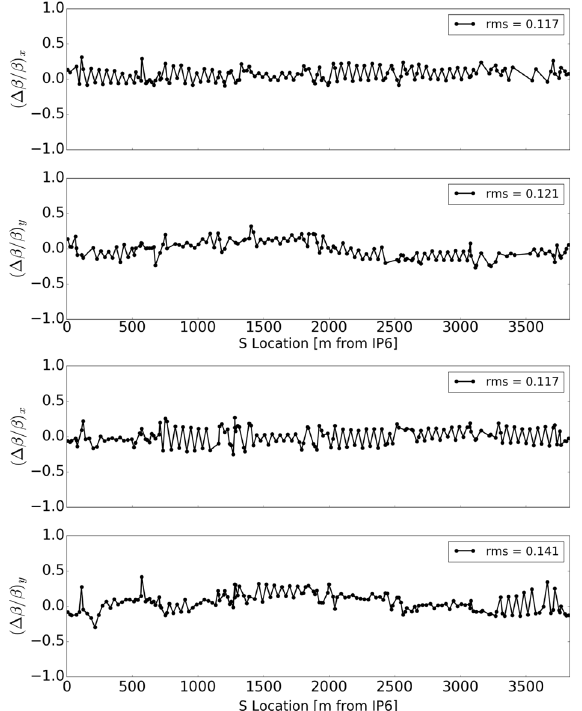
FIG. 11. Measured β -beat ð Δ β = β Þ vertical planes (top) and the Yellow horizontal and vertical planes